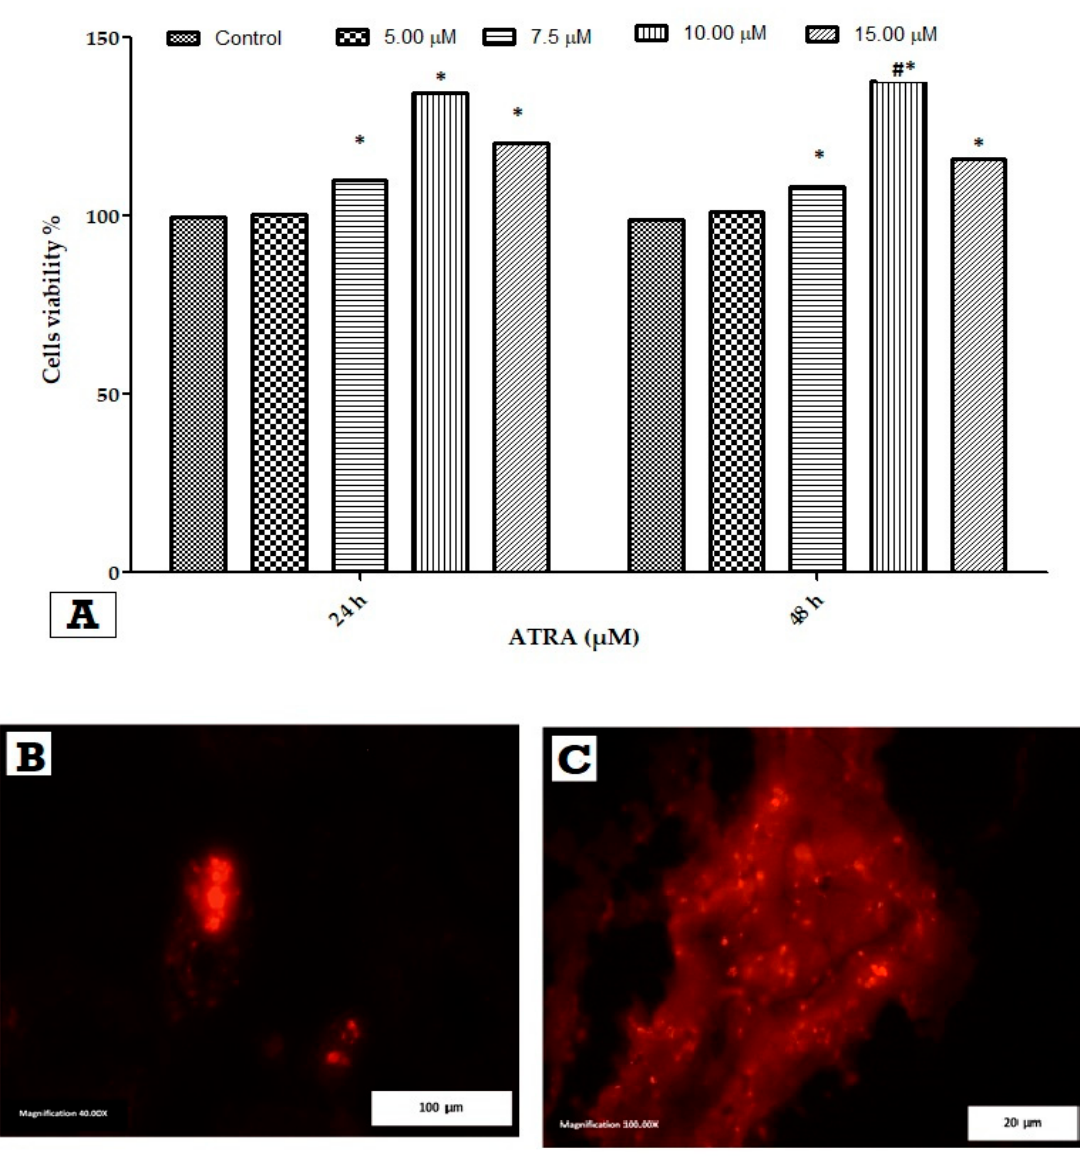
Figure 2. WJ-MSCs viability and homing. ( A ) shows the effect of ATRA on WJ-MSCs viability, * * compared with control, # compared with 10 µ M ATRA at 24 h. Homing of labelled WJ-MSCs with BrdU in kidney tissue at 100 µ m scale bar and magnification 400 × , and in ( B ) at 20 µ m scale bar and magnification at 100 × . ( C ) shows the enlargement and irregularity of BrdU-labelled capsular nuclei (arrow). Representative microphotographs of a kidney section were obtained 3 days after ischemia followed by intravenous administration of 7 × 10 ⁶ MSCs by 10 min.